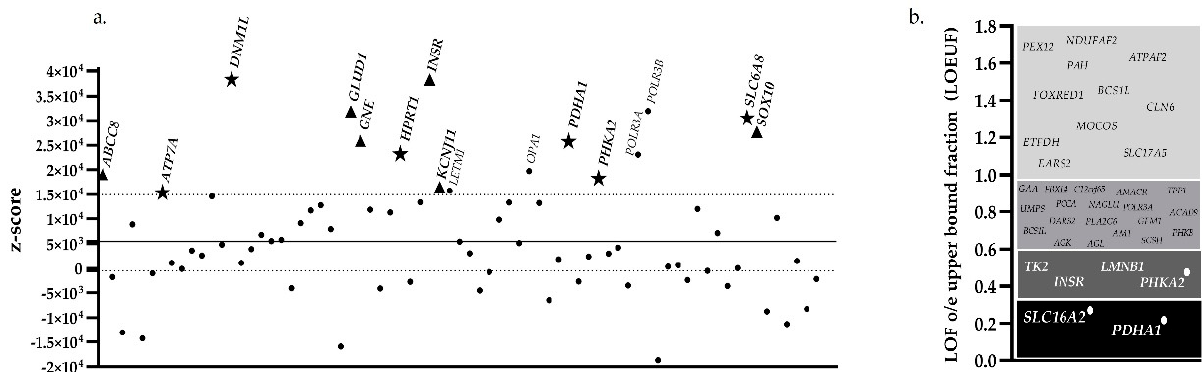
Figure 4. ( a ) Representation of z-scores for autosomal dominant ( ▲ ) and X-linked ( ★ ) genes that are predicted to be more intolerant to functional variation. ( b ) LOEUF scores from gnomAD, and haploinsufficiency (HI) scores from ClinGen data. Low LOEUF scores (<0.35) indicate strong selection against predicted loss-of-function (pLoF) variation in a given gene. Genes indicated with a white circle have the highest score (3), meaning there is sufficient evidence for haploinsufficiency according to ClinGen.